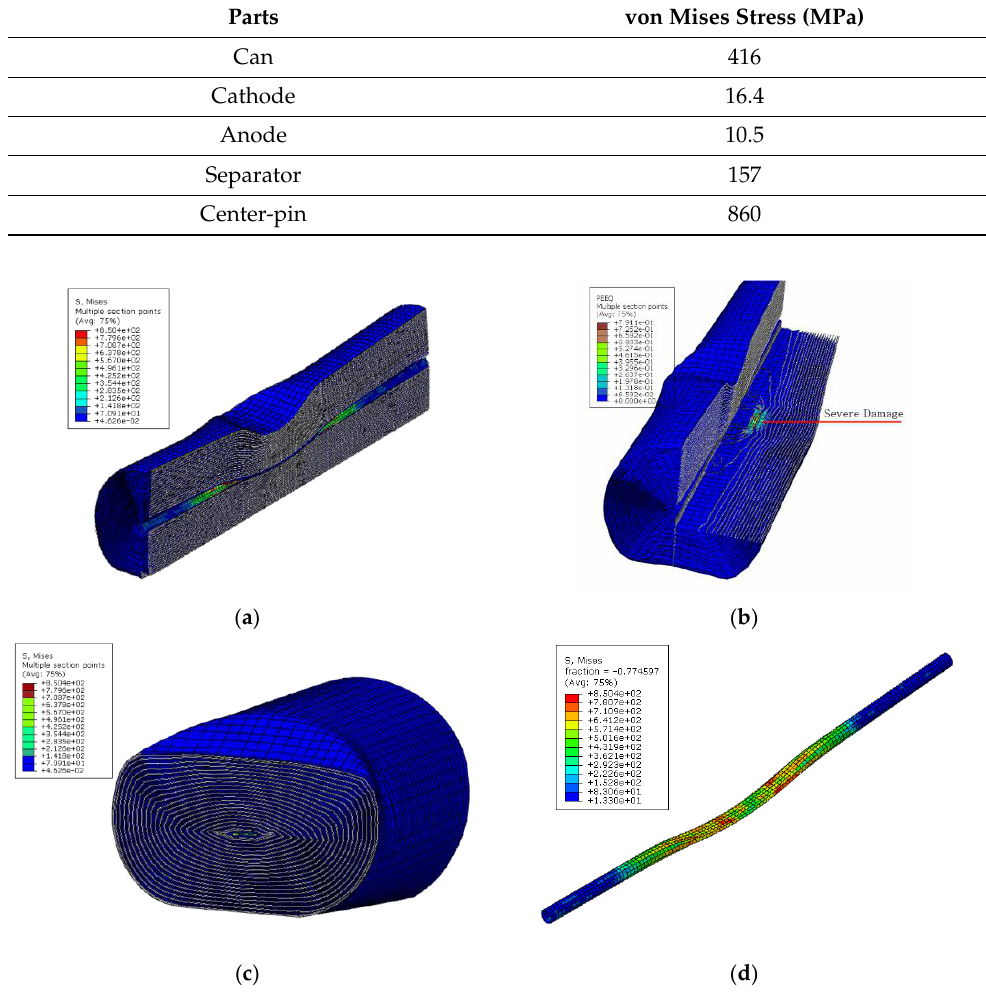
Figure 5. ( a ) Stress distribution of the deformed jelly roll with a center-pin, ( b ) damage onset location of a set of separators predicted from the simulation, ( c ) longitudinal section of the deformed jelly roll, and ( d ) deformed center-pin. Some like 8.504e+02 means 8.504 × 10 2 .